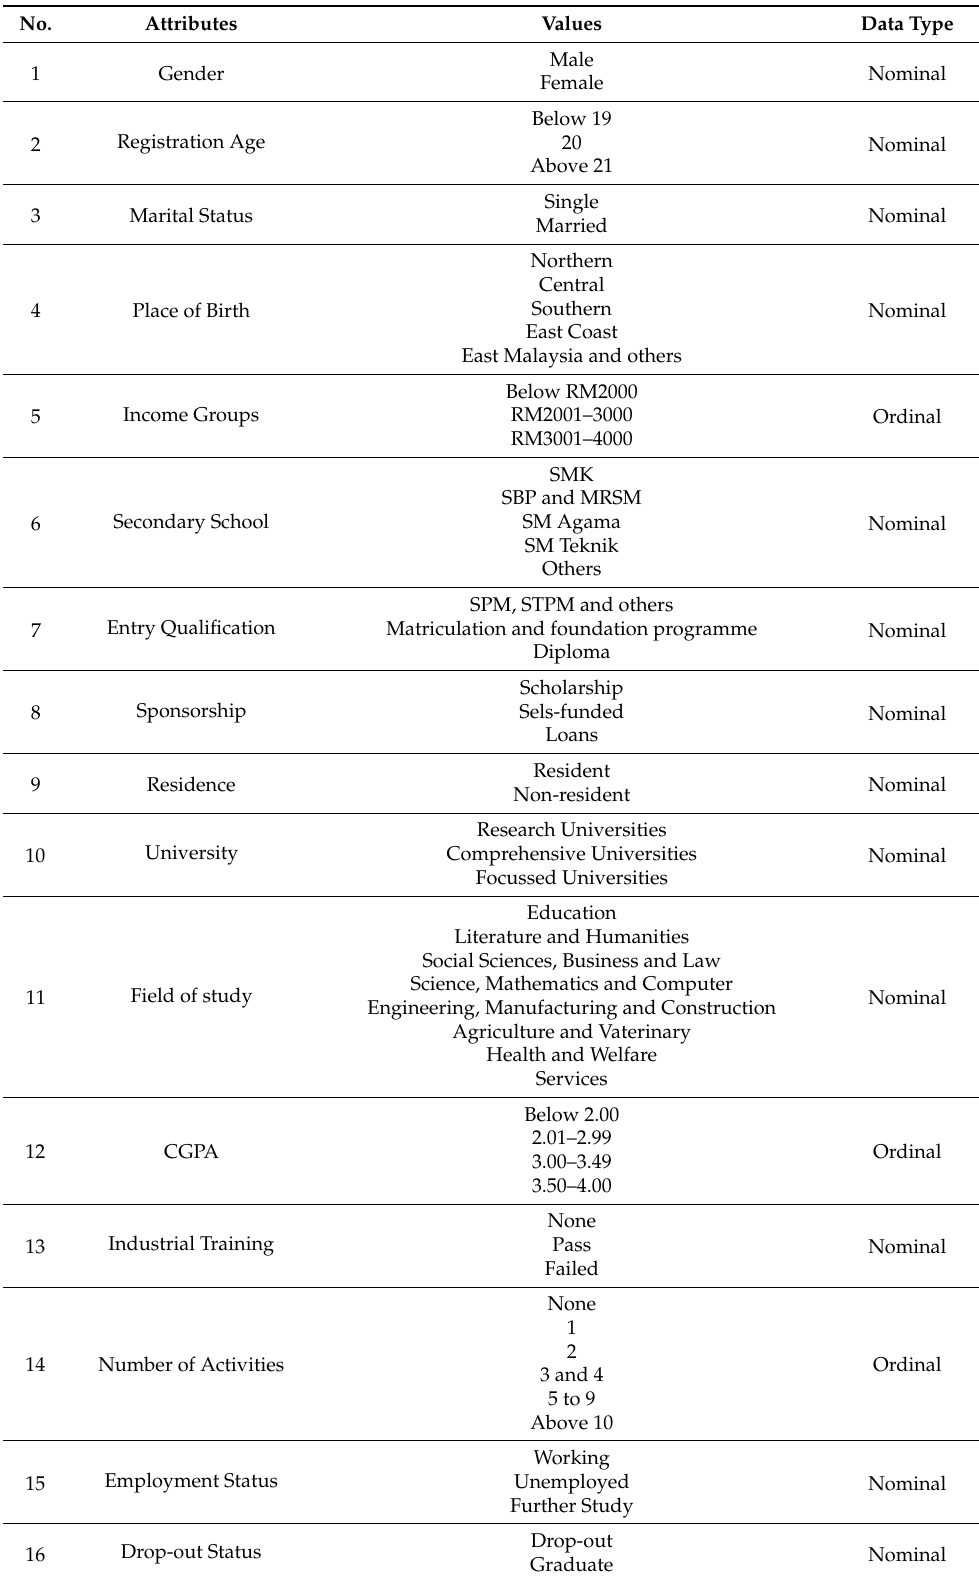
Table 2. List of attributes and